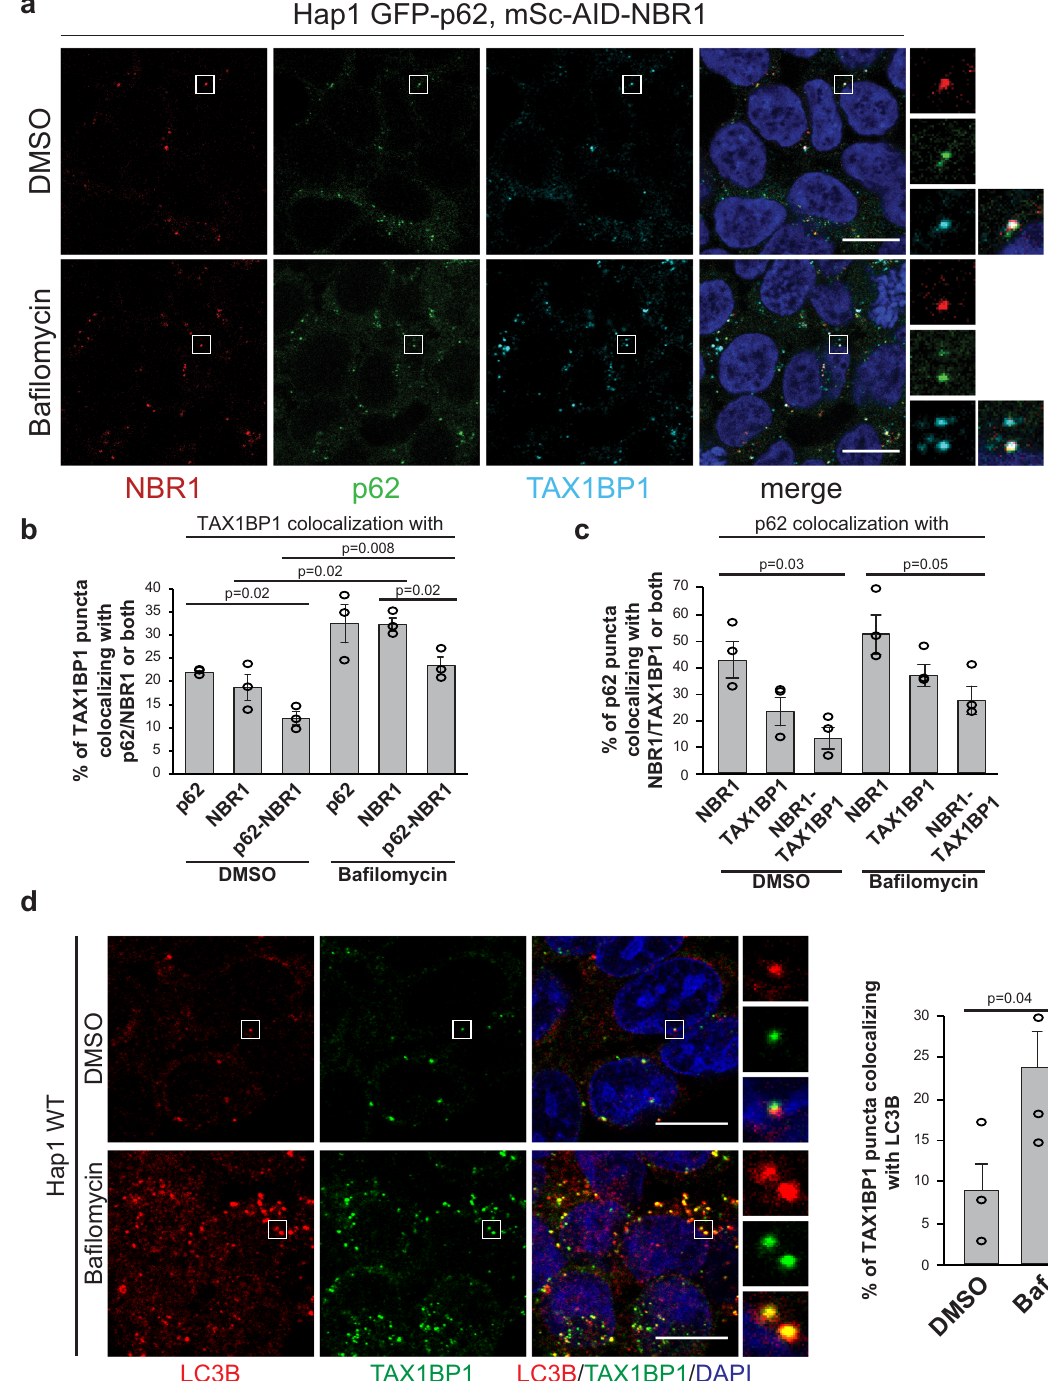
Fig. 1 p62, NBR1, and TAX1BP1 colocalize in ubiquitin-containing condensates. a The cargo receptors NBR1 and p62 were endogenously tagged with mScarlet-AID and GFP tags respectively, using CRISPR (Supplementary Fig. 1b). Cells were left untreated (DMSO) or treated with ba fi lomycin (400 nM for 2 h) and fi xed. After fi xation, NBR1 and p62 were detected using their endogenous fl uorescent tags, while TAX1BP1 was detected by immuno fl uorescent staining. Scale bar, 10 µ m. Validation of endogenous protein tagging in the cell line used for the experiment is shown in Supplementary Fig. 1c and d. b , c Colocalization of TAX1BP1 with p62, NBR1 or both ( b ) and colocalization of p62 with TAX1BP1, NBR1 or both ( c ), based on the experiments in Fig. 1a. Colocalization analysis was performed with ImageJ. Average percentage of colocalization and SEM for three independent experiments are plotted. An unpaired, two-tailed Student ’ s t test was used to estimate signi fi cance. P values are indicated in the fi gure. d Colocalization of TAX1BP1 with LC3B in HAP1 WT cells mock-treated with DMSO or treated with ba fi lomycin (400 nM) for 2 h. LC3B and TAX1BP1 were detected by immuno fl uorescence staining. Scale bar, 10 µ m. For the colocalization analysis, average percentages of colocalization ± SEM for n = 3 are plotted. An unpaired, two-tailed Student ’ s t test was used to estimate signi fi cance. P values are indicated in the fi